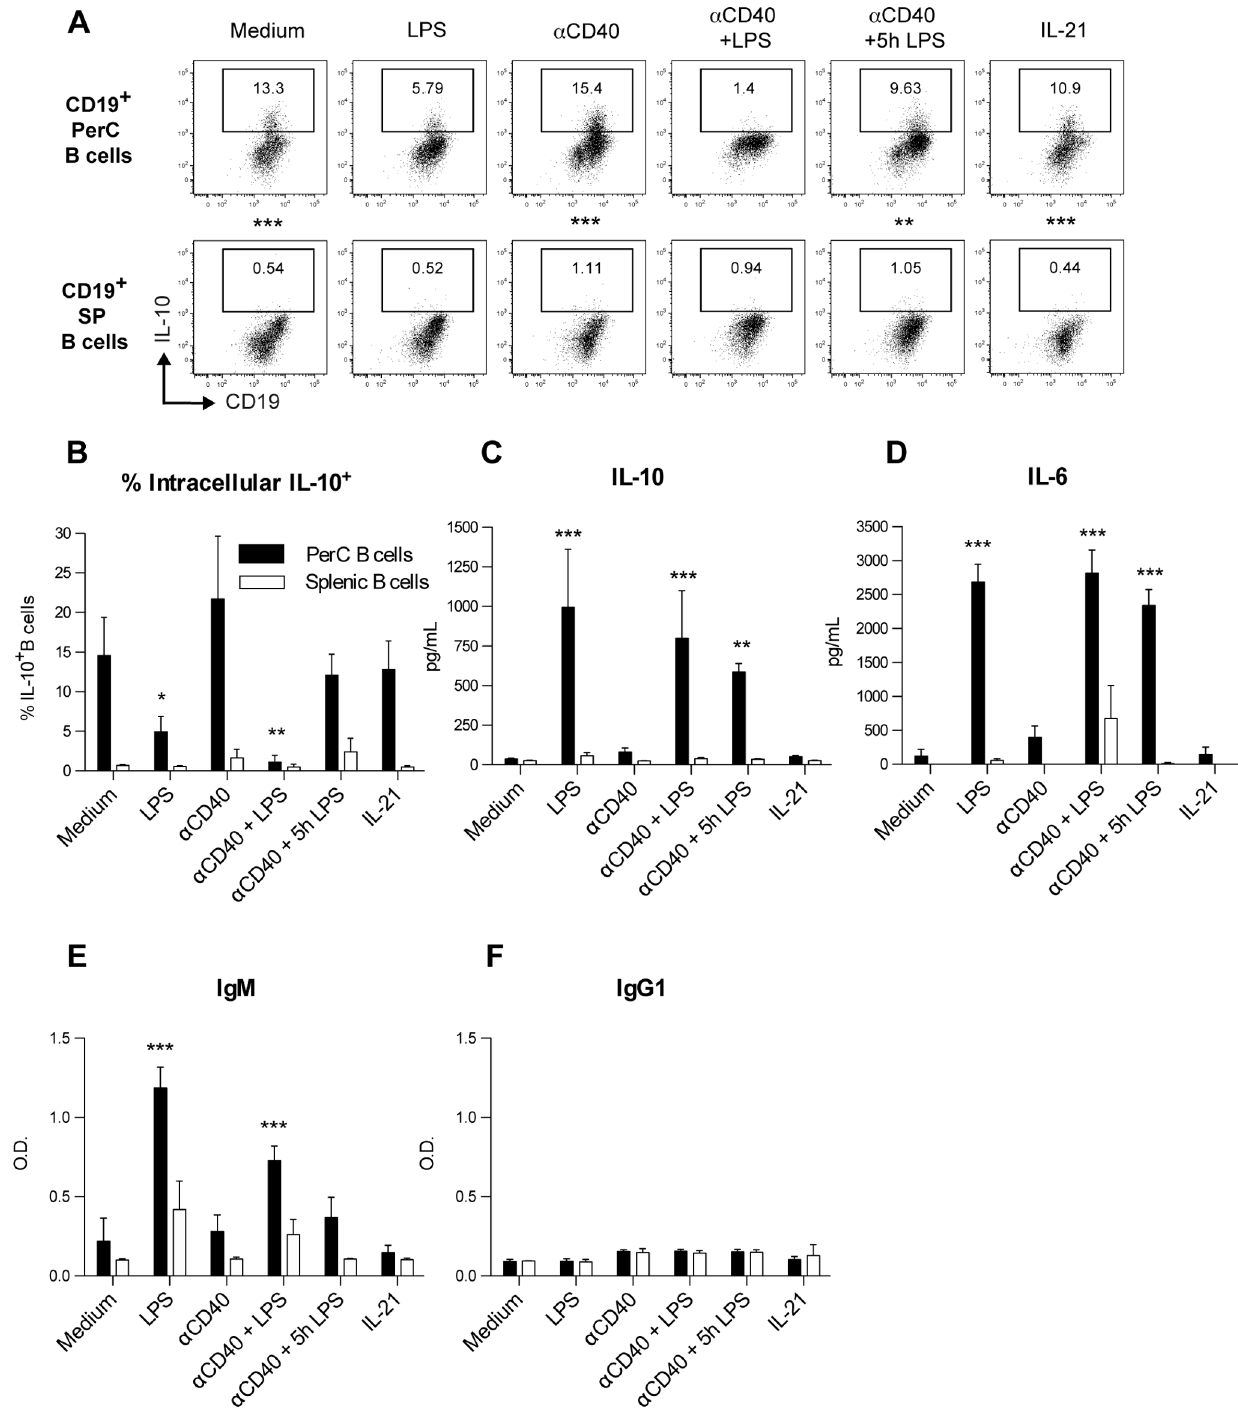
Figure 1. Invitro activated PerC B and PerC B-1a cells produce IL-10 and IL-6. Splenic B cells and PerC B cells were cultured for 48 h in the presence of medium only or indicated stimuli (see materials and methods). Intracellular IL-10 staining was performed after additional stimulation with PMA/ionomycin/LPS and both representative flow cytometric plots (A) and the percentage of IL-10 + B cells (B) are shown, whereas the levels of IL-10 (C), IL-6 (D), IgM (E) and IgG1 (F) were determined directly from the supernatant (before restimulation took place) using Luminex (IL-10 and IL-6) and ELISA (IgM and IgG1). Shown in B-F are the mean 6 S.D. of pooled results from two identical replicate experiments (with 2–5 technical replicates each) that produced similar data. Statistically significant differences between PerC- and splenic B cells after stimulation were calculated using a two- way ANOVA with Bonferroni post-hoc test (A), whereas statistically significant difference between the various stimuli and the medium control of PerC B cells (B-F) were calculated using a one-way ANOVA with Bonferroni post-hoc test. * p , 0.05, ** p , 0.01, *** p , 0.001.